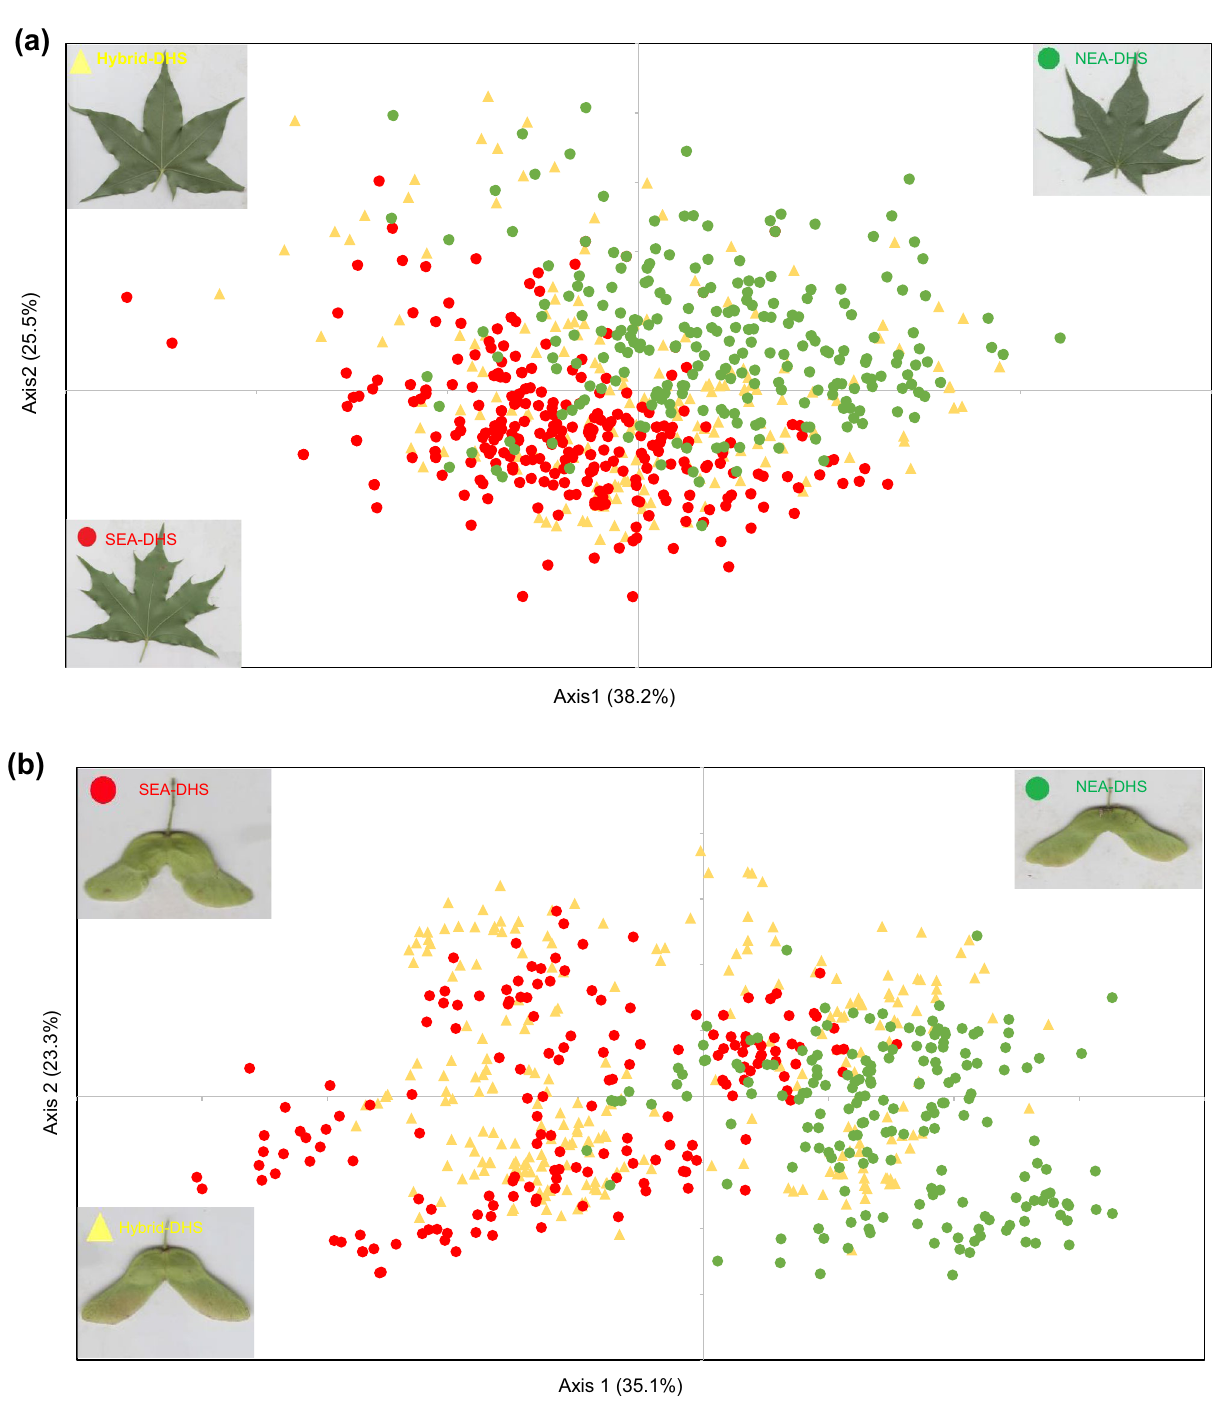
Figure 3. Morphological variation in the leaves ( a ) and fruits ( b ) of southern and northern East Asia lineages of the Acer species complex in the Daheishan National Nature Reserve based on principal component analysis. SEA-DHS: Southern East Asia lineage of the Acer species complex in the DHS; NEA-DHS: Northern East Asia lineage of the Acer species complex in the DHS; Hybrid-DHS: hybrids between SEA-DHS and NEA-DHS